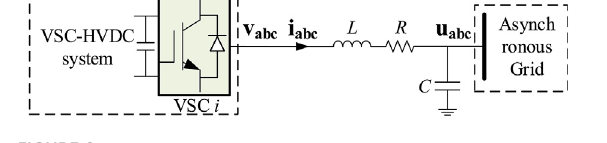
Diagram of a VSC in the VSC-HVDC system, where u abc represents the AC voltage of the asynchronous grid, v abc and i abc are the output AC voltage and AC current of the VSC-HVDC system, and R and L denote the resistance and inductance of the interfacing reactor,